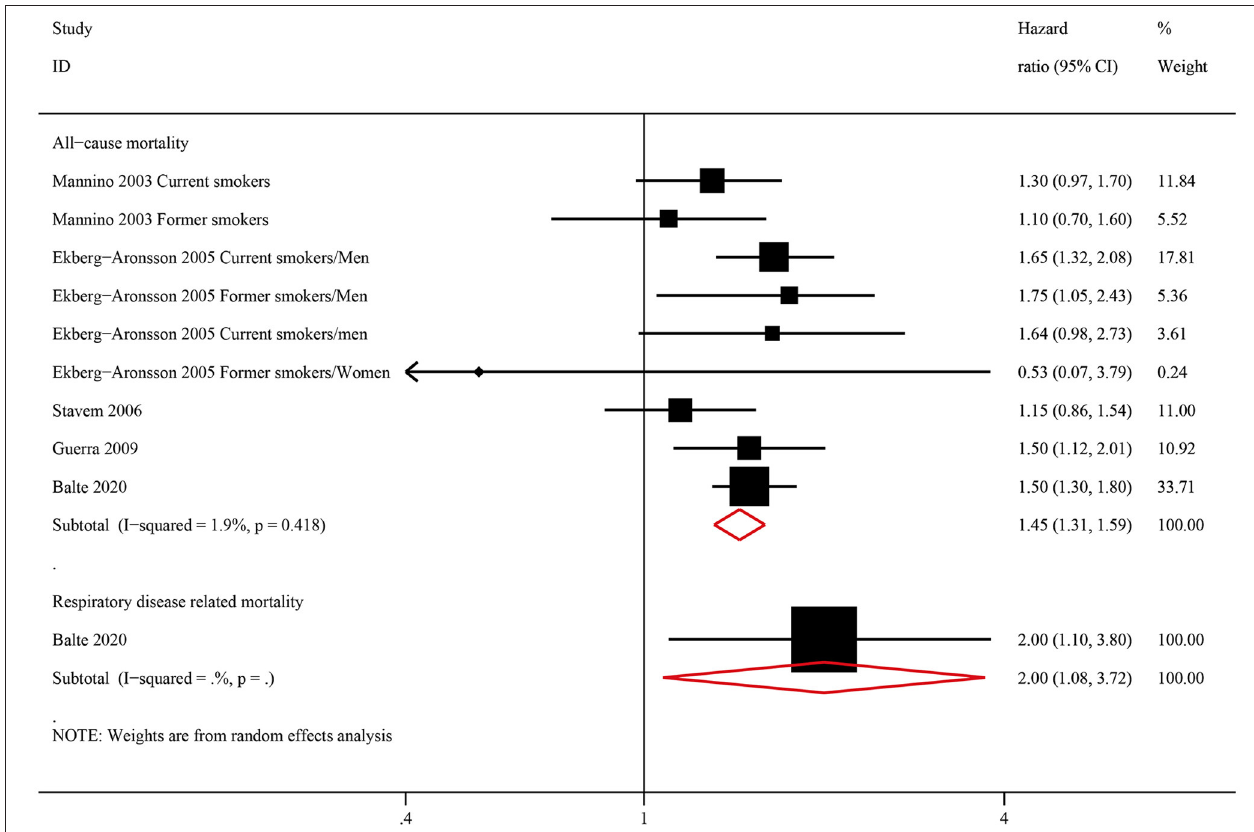
FIGURE 4 | Forest plot of the risk of all-cause mortality and respiratory-related mortality in ever smokers with non-obstructive chronic bronchitis compared with ever smokers without non-obstructive chronic bronchitis. Without non-obstructive chronic bronchitis was defined as normal spirometry and no chronic bronchitis.